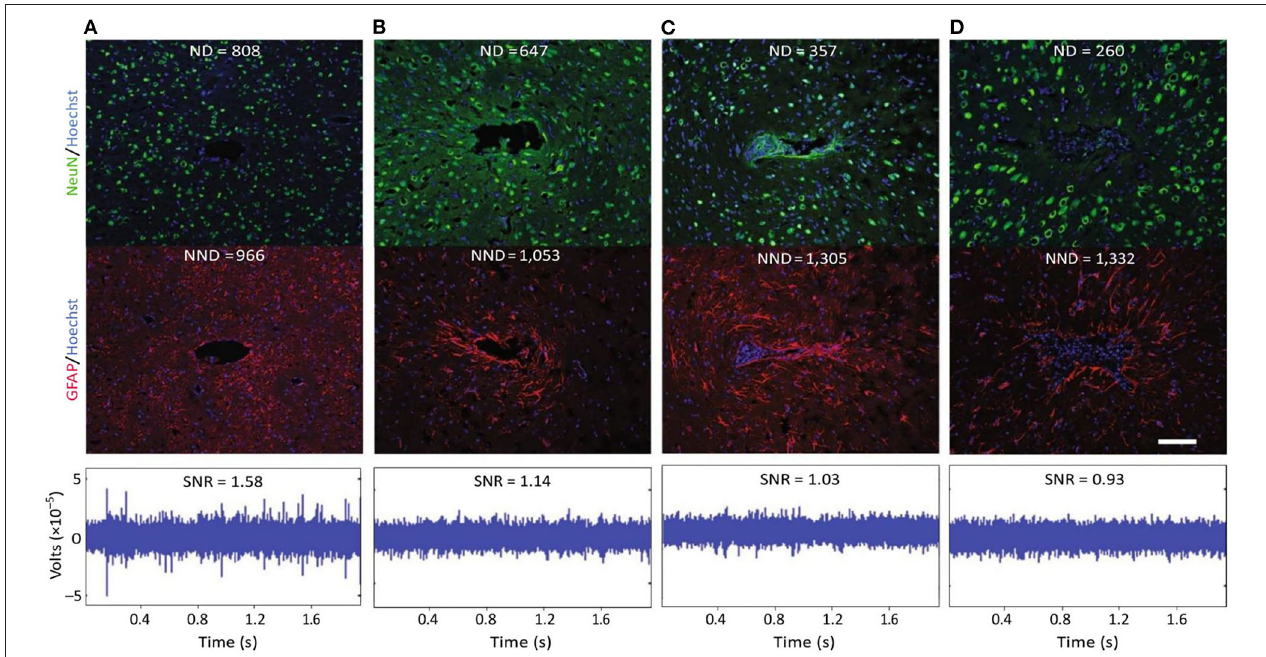
FIGURE 4 | Evidence for a negative impact of increased gliosis on recording quality. (A–D) Representative images from four animals demonstrate the range of endpoint histological outcomes (from “good” to “poor,” left to right). Neuronal nuclei (NeuN, green) and astrocytes (GFAP, red) surrounding probe tracts are shown, and the associated average neuronal and non- neuronal density data are listed [area binned cell counts, neuronal density (ND), and non-neuronal density (NND), in cells mm − 2 ]. Recording segments with signal-to-noise-ratio (SNR) values representative of the average value for each animal are depicted. Recording quality improved with decreased NND and increased ND/NND ( P < 0.05, Spearman’s ρ , n = 6). Impedance increased with increased NND ( P < 0.05, Spearman’s ρ , n = 6). Scale bar, 100 µ m. This figure was generated after additional analysis on data collected in Purcell et al. (2009). Figure and caption adapted with permission from Salatino et